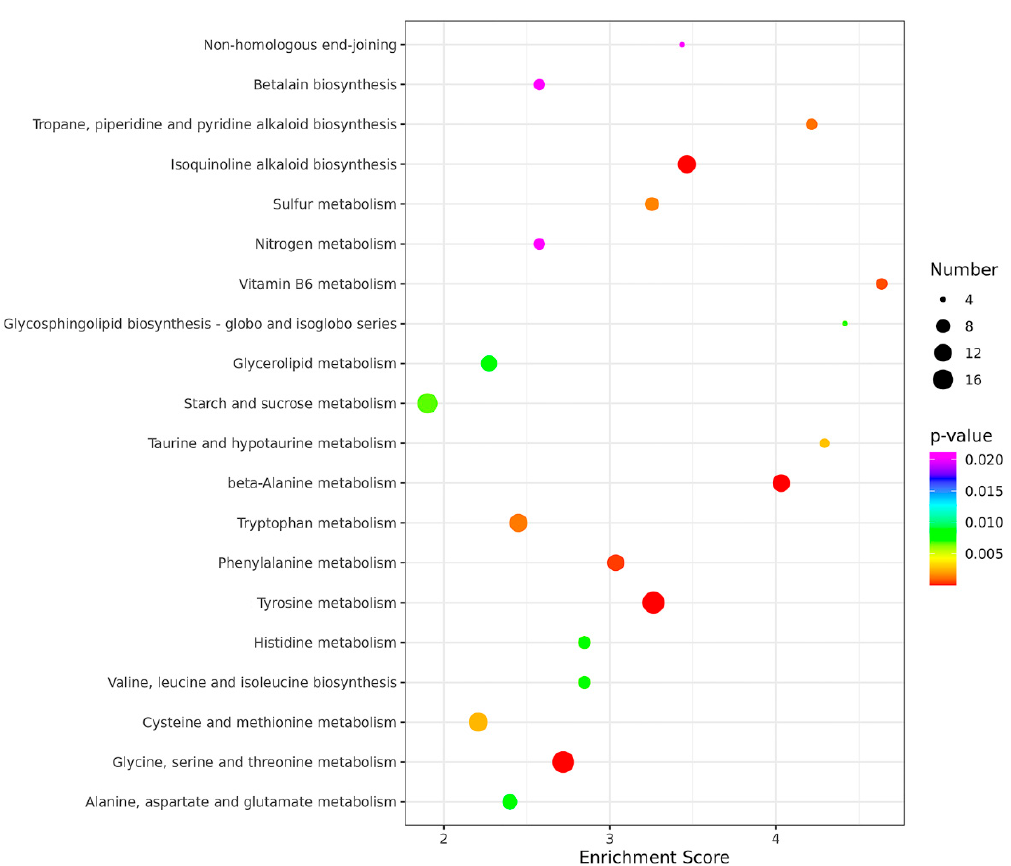
Figure 7. The KEGG pathways enriched in the ∆ moade12 mutant. The enrichment score represents the ratio of differentially expressed genes to all annotated genes in the same pathway. Higher enrichment scores correlate with the degree of enrichment. The top 20 enriched pathways are shown.